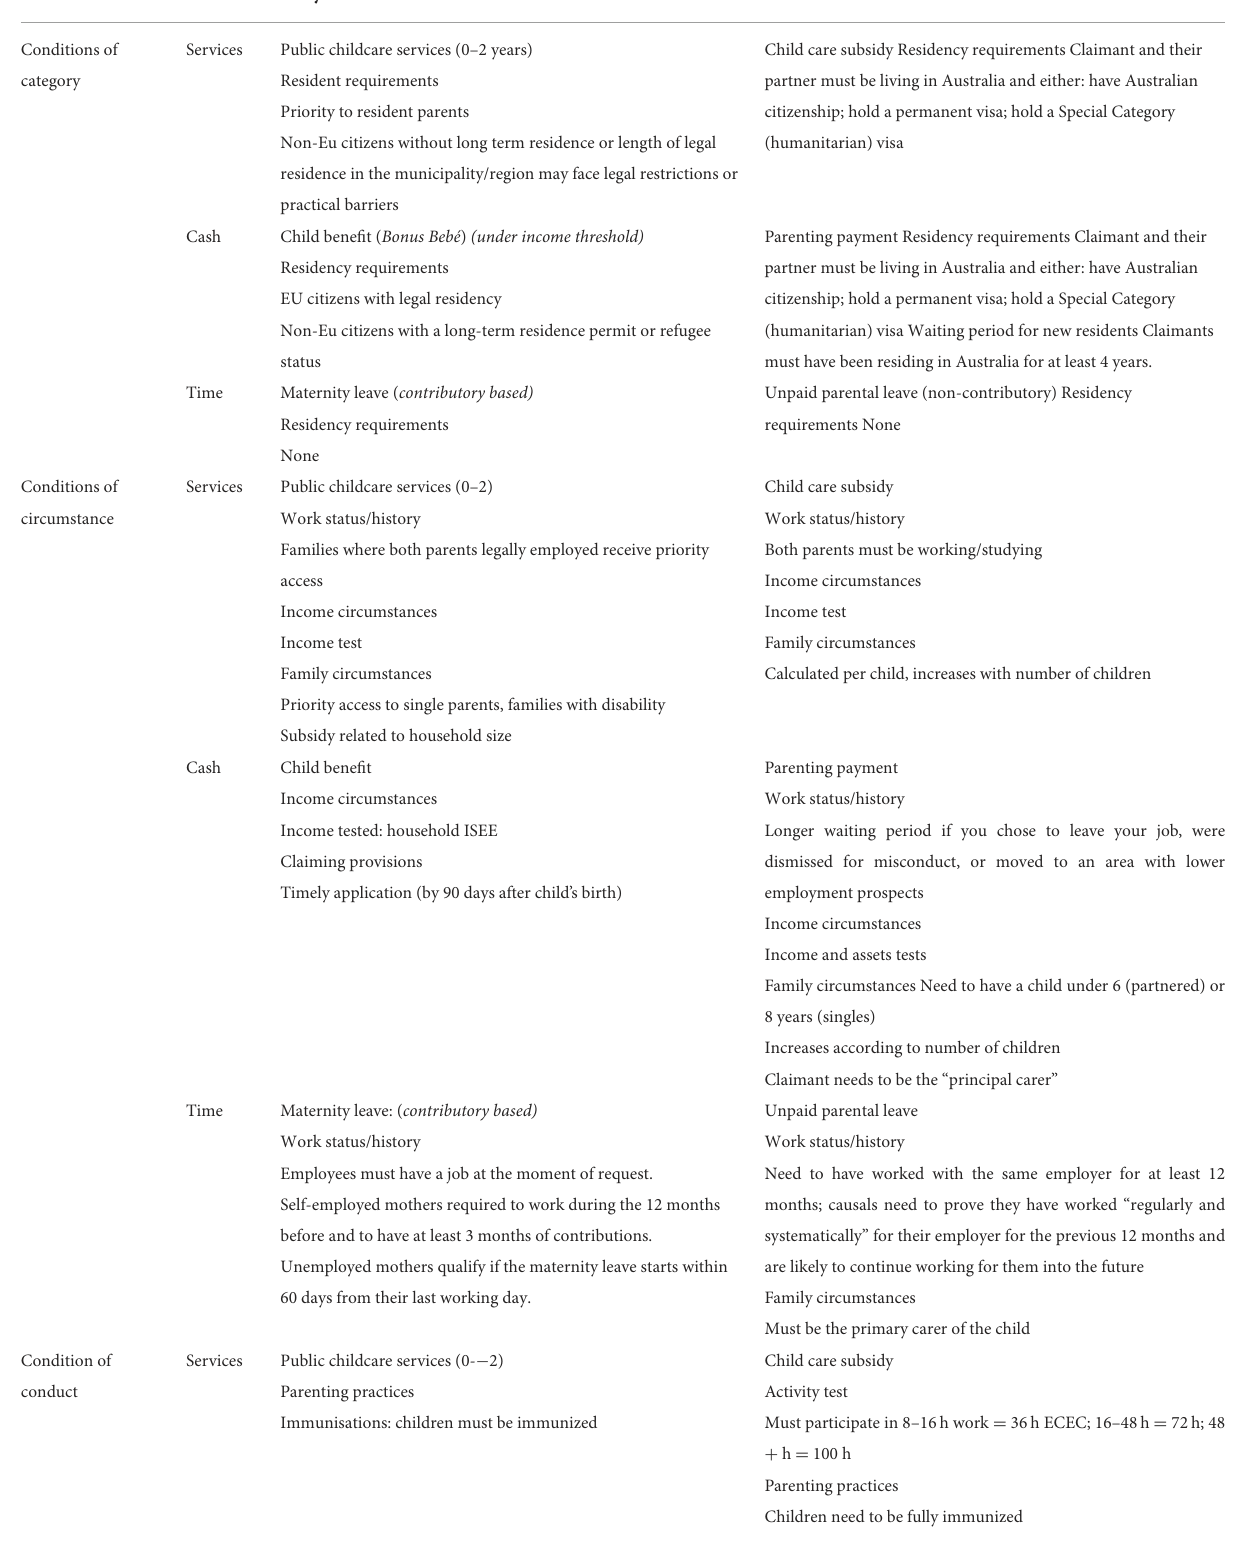
TABLE 1 Comparison of conditions for receipt of ECEC services and benefits for migrant families, Italy and Australia